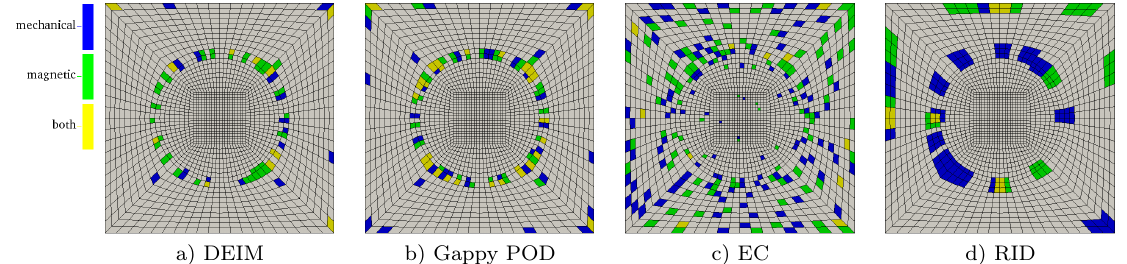
Figure 11. ( a ) values and distribution of weights ( b ) ω u and ( c ) ω y in with m u = 120 and m y = 110 elements. The yellow circles mark the boundary between matrix and inclusion. For better quality, we point to the online version of the article.